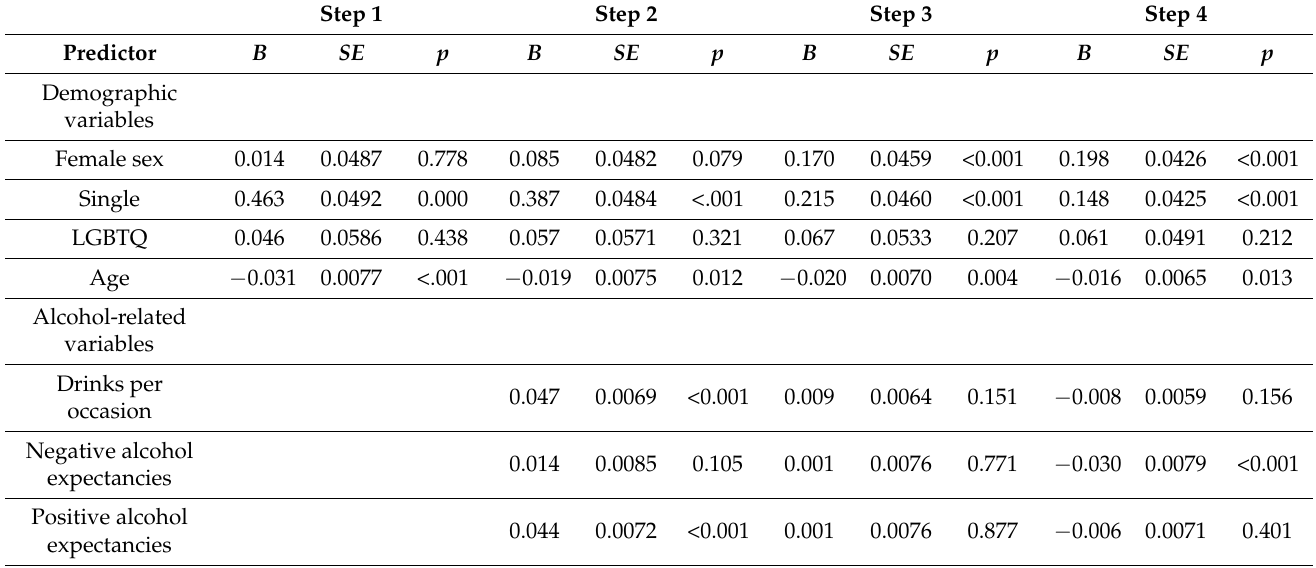
Table 3. Results of negative binomial regression models predicting alcohol-related sexual consequences. Step 1 Step 2 Step 3 Step